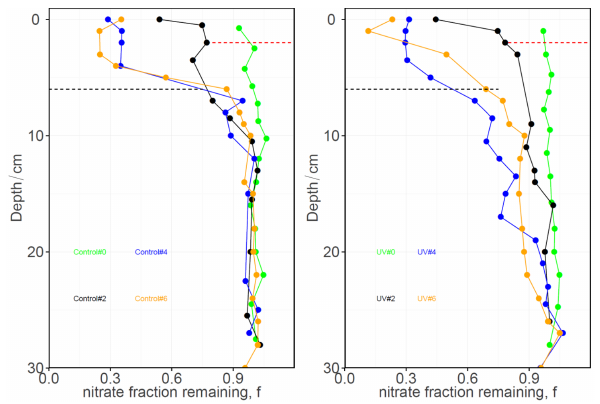
Figure 3. Plot of the nitrate fraction remaining in the snow ( f ) with depth. Control samples (reduced solar UV) are plotted in the left panel and UV-exposed samples are plotted in the right panel. The numbers denote the sampling events, which were carried out at 10-day intervals from 2 December 2011 to 30 January 2012. The dashed lines show the depth where external factors (mainly mixing) play a significant role.